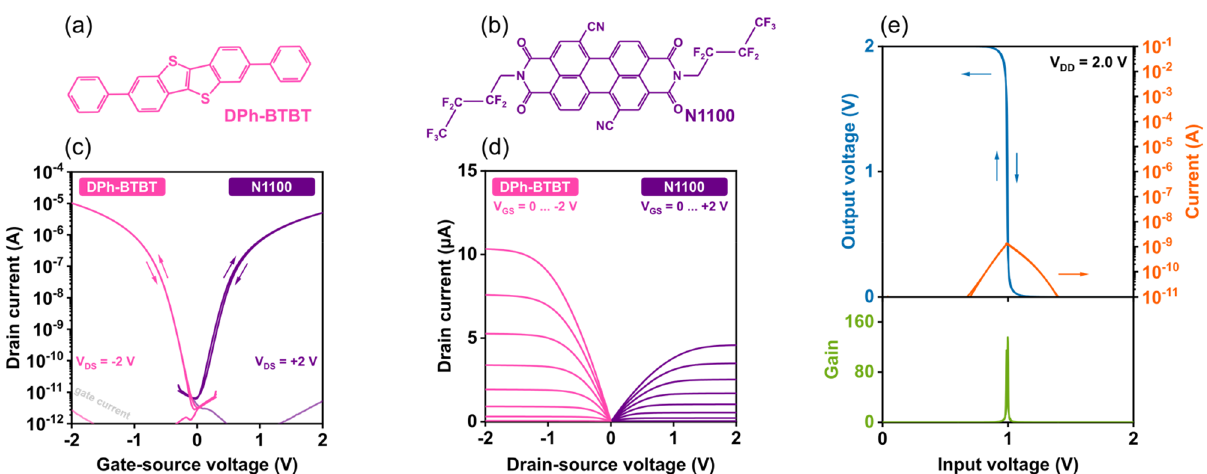
Figure 10. Chemical structures of the organic semiconductors ( a ) 2,7-diphenyl[1]benzothieno[3,2-b] benzothiophene (DPh-BTBT) and ( b ) (PTCDI-(CN) 2 -(CH 2 C 3 F 7 ) 2 ; Polyera ActivInk N1100). ( c ) Transfer and ( d ) output characteristics of a DPh-BTBT p-channel TFT and an N1100 n-channel TFT. The TFTs have a channel length of 40 µm and a channel width of 1000 µm. ( e ) Transfer characteristics of a complementary